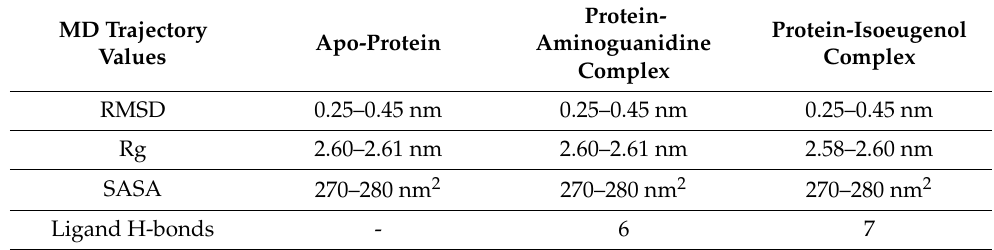
Table 7. MD trajectory values of isoeugenol and aminoguanidine complexed with HSA.